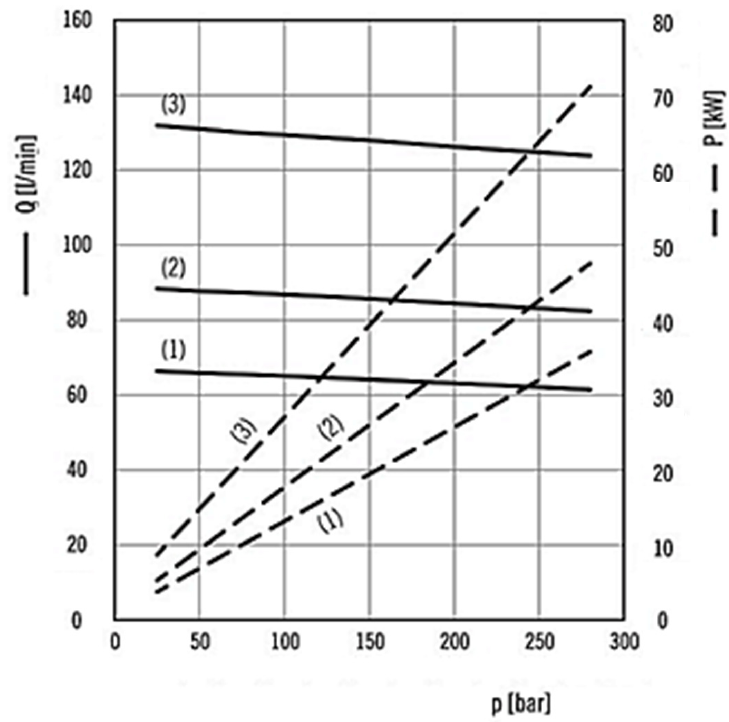
Figure 7. Nominal flow rate function of pressure, power and rotational speed. Curves are parameterized as (1) 1500 rpm, (2) 2000 rpm, and (3) 3000 rpm.